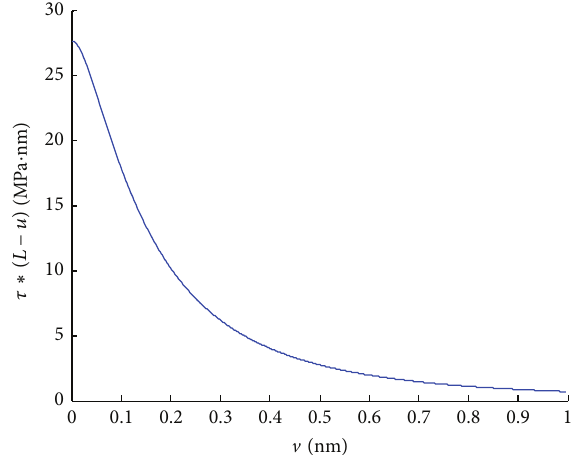
Figure 4: The relationship of shear stress and displacement based on van der Waals